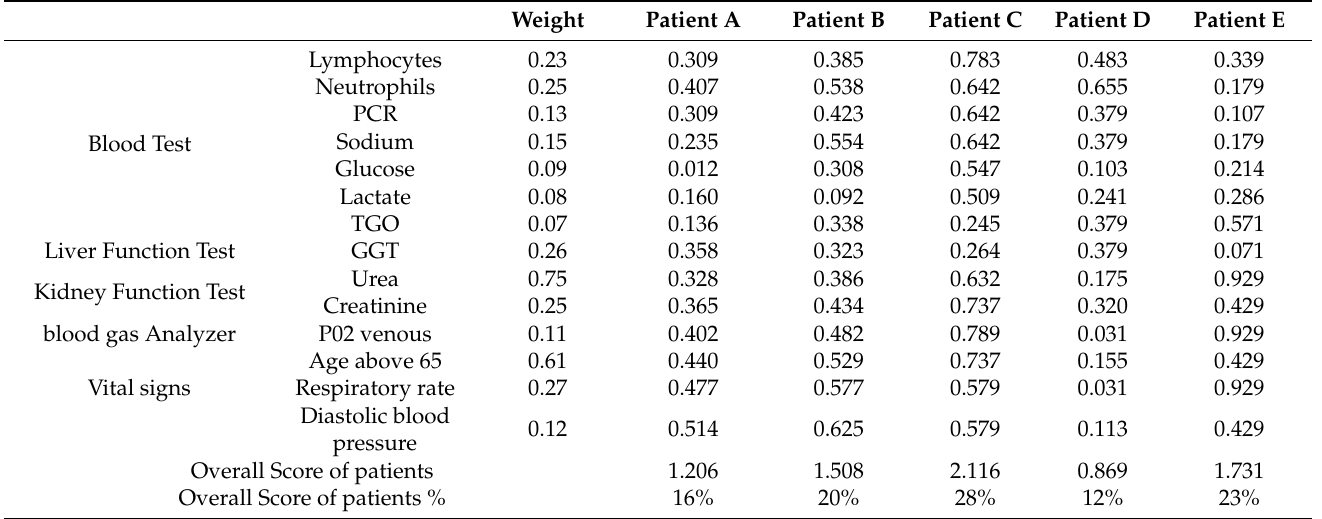
Table 8. Overall score of each patient’s